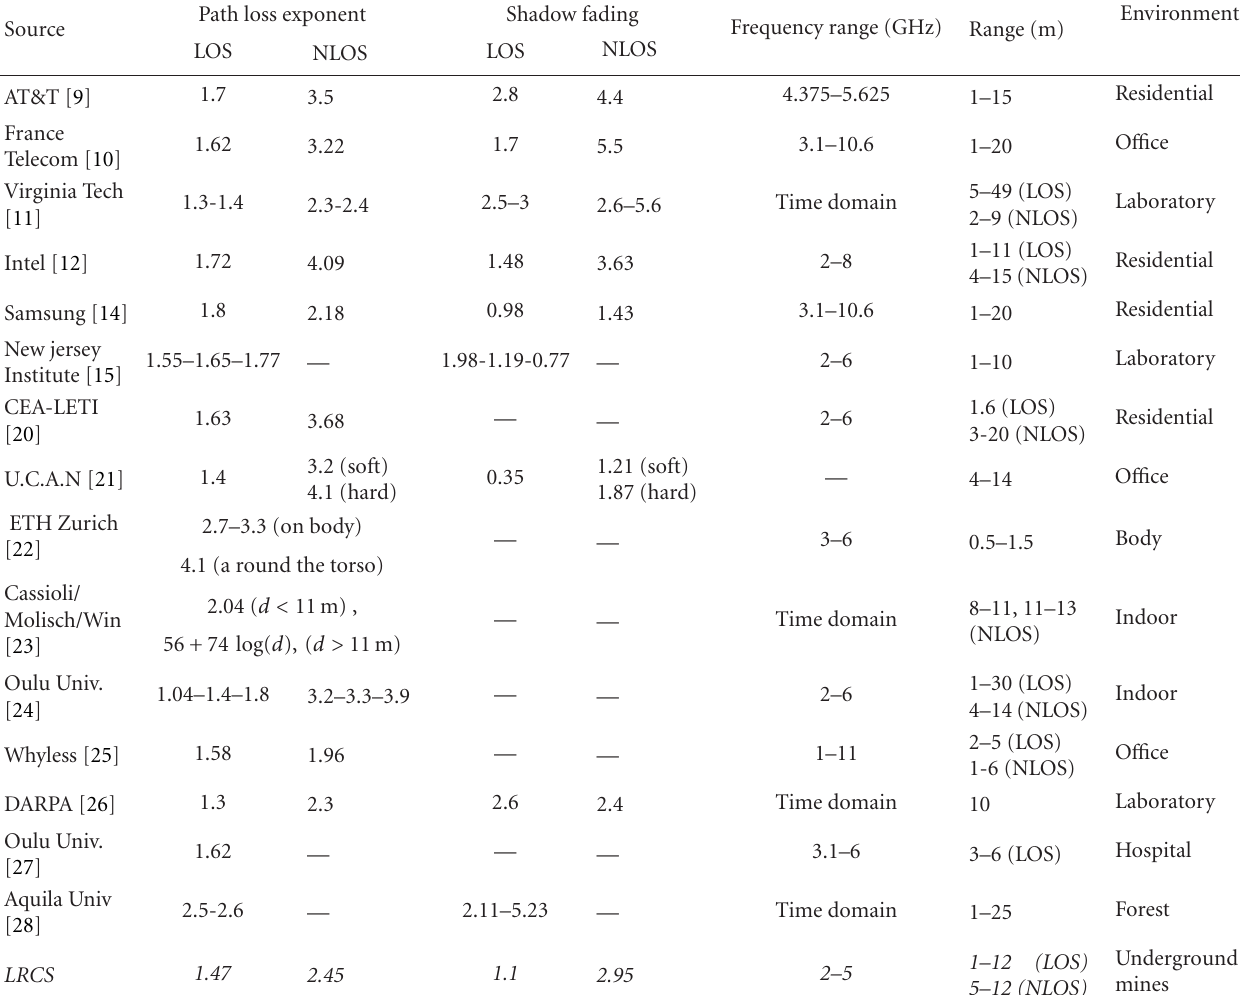
Table 2: The reported values on large scale fading based on previous measurement